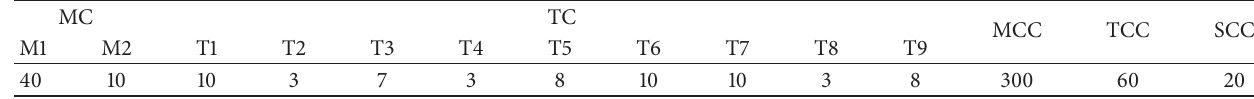
Table 5: Cost indexes for the example part in Figure 2.